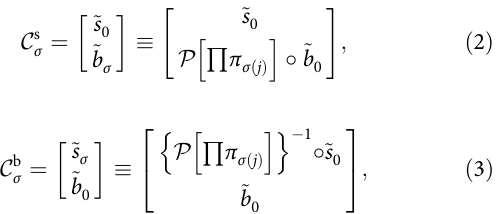
the fi nal con fi guration in both the s- and b-frames is given by: